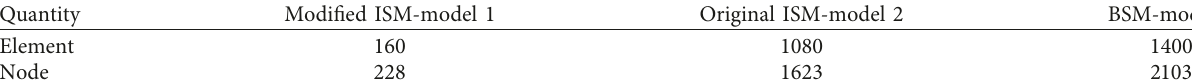
Table 2: Numbers of elements and nodes of different substructure models.